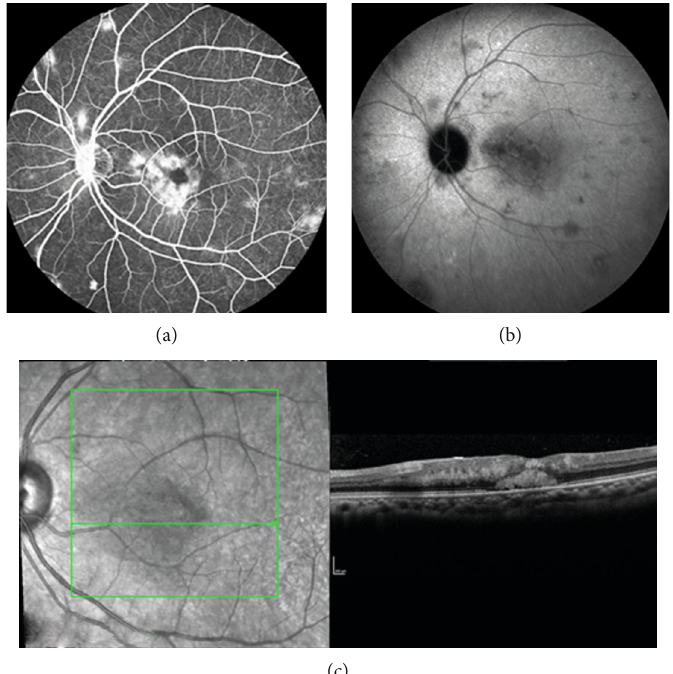
Figure 3: Case 1: left eye at 10-month follow-up. (a) Late-phase fl uorescein angiogram showed regression of the vasculitis, remaining late di ff usion of the optic nerve, and staining of the macular and peripheral scarring retinal lesions. (b) Late-phase ICGA demonstrated a drastic improvement with persistence of some discrete hypo fl uorescent spots probably corresponding to the scarring lesions seen on eye fundus and FA. (c) Spectral domain optical coherence tomography in the left eye showed a retrofoveolar scar with disruption of the retinal pigment epithelium and a loss of macular inner retinal structure.